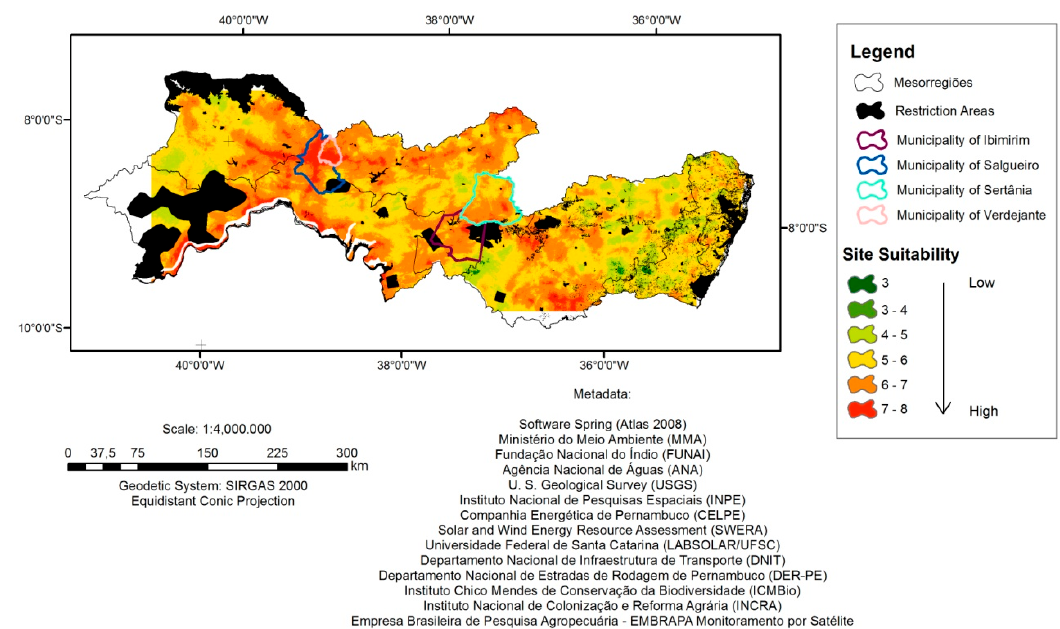
Figure 11. Site Suitability Map for the Installation—Scenario Starting Point.